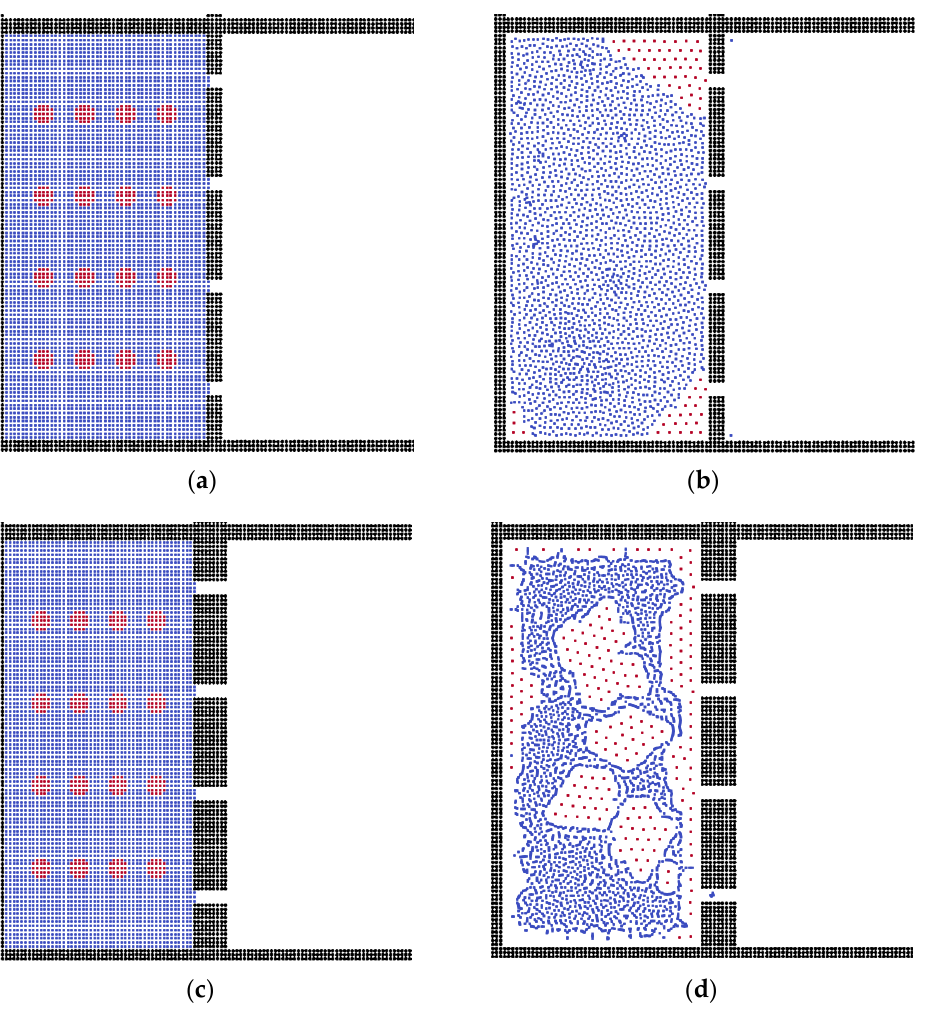
Figure 6. Results of separation with different thicknesses of membrane, ( a , c ) are the initial conditions,